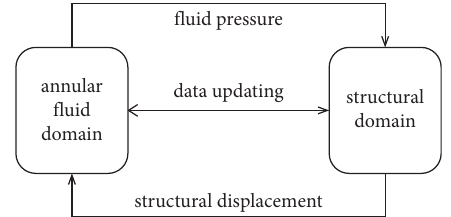
Figure 3: Data transfer diagram between fluid and structure.